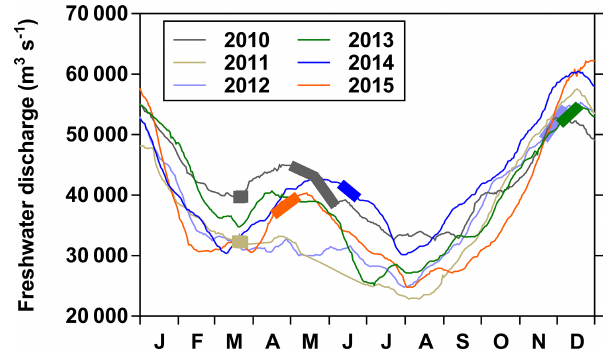
Figure 1. Freshwater discharge (m 3 s − 1 ) of the Congo River at Kin- shasa from 2010 to 2015, with an indication of field expedition du- ration (thick